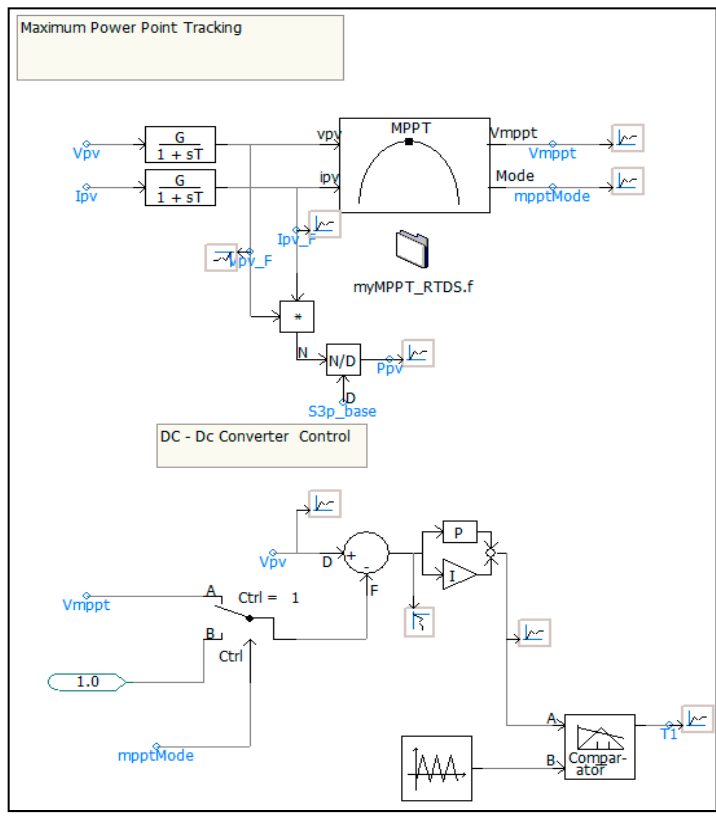
Figure 26. DC/DC Converter control scheme in power system computer-aided design (PSCAD).